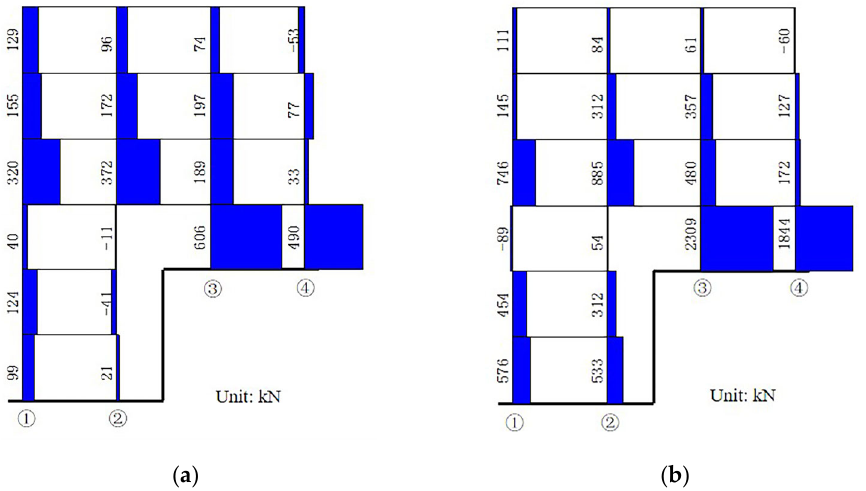
Figure 7. The column shear along the slope direction at the time of maximum base shear: ( a ) a PG, x = 0.07 g; ( b ) a PG, x = 0.62 g. Figure 8a,b show the column shear across the slope direction. For the upper ‐ embed ‐ ding story, the shear forces of columns at Axis 1 and Axis 2 are lower, and the proportion of the shear force of these columns is increased compared with those along the slope di ‐ rection. It can be found that the shear force of the columns at Axis 1 and Axis 3 are com ‐ monly larger than those at Axis 2 and Axis 4, and the increase in the seismic intensity has not caused obvious changes in the distribution of the shear force of columns.